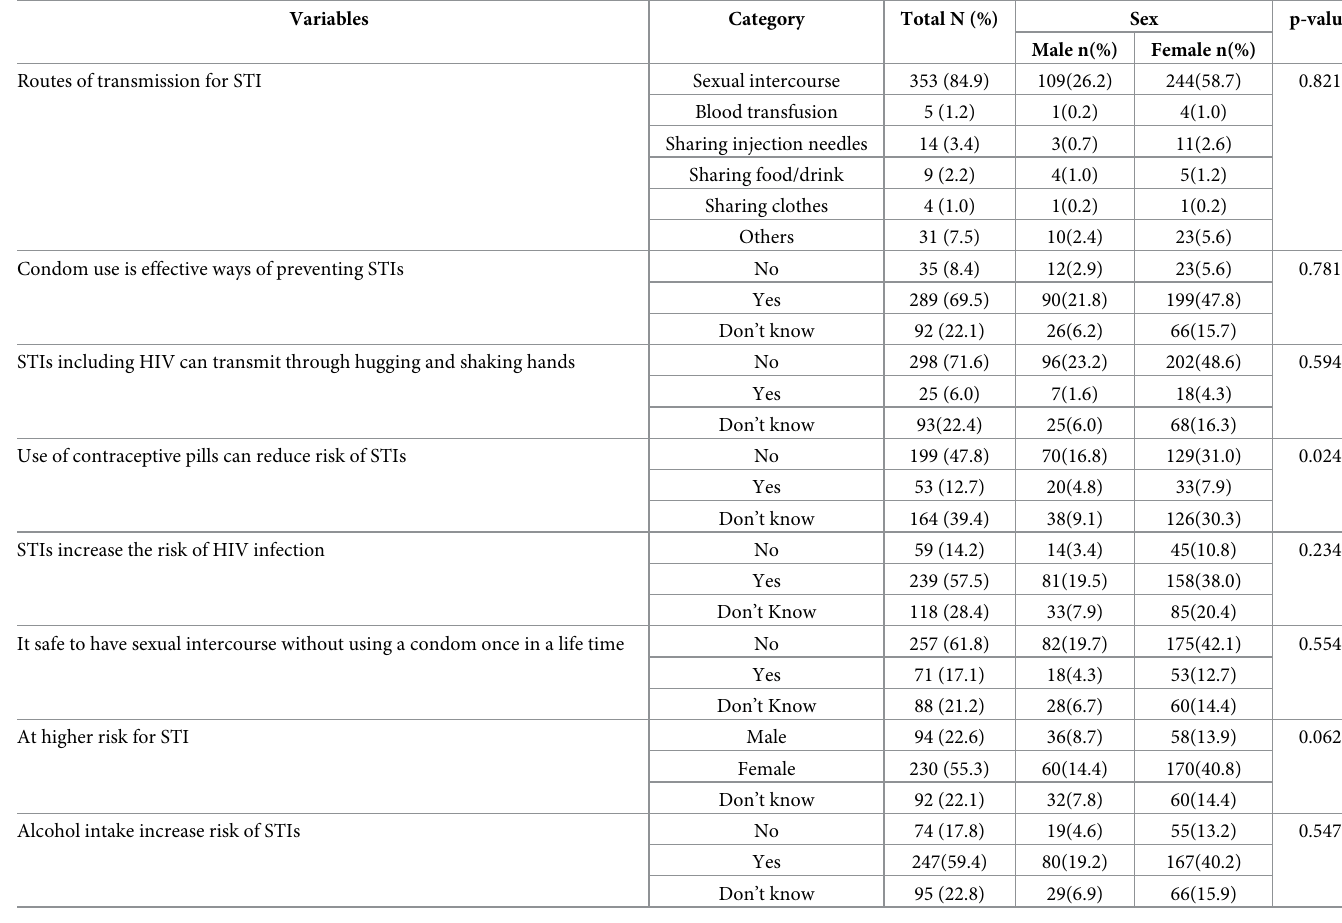
Table 2. Knowledge/beliefs related characteristics among males and females youth-friendly services Attendees at selected health facilities in Hawassa city, Sidama Regional State, Ethiopia, May 1 to August 30, 2021 (N =